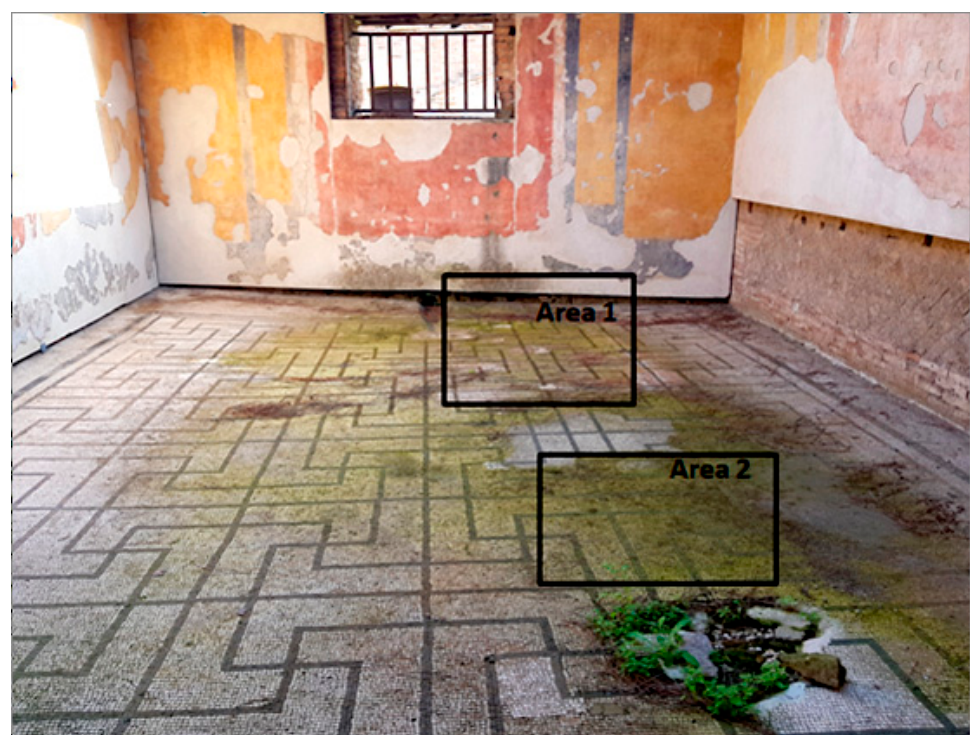
Figure 2. XIX room of “Insula delle Muse” at the Archaeological Park of Ostia Antica. The figure shows the treated Areas 1 and 2 of the biodeteriorated mosaic.